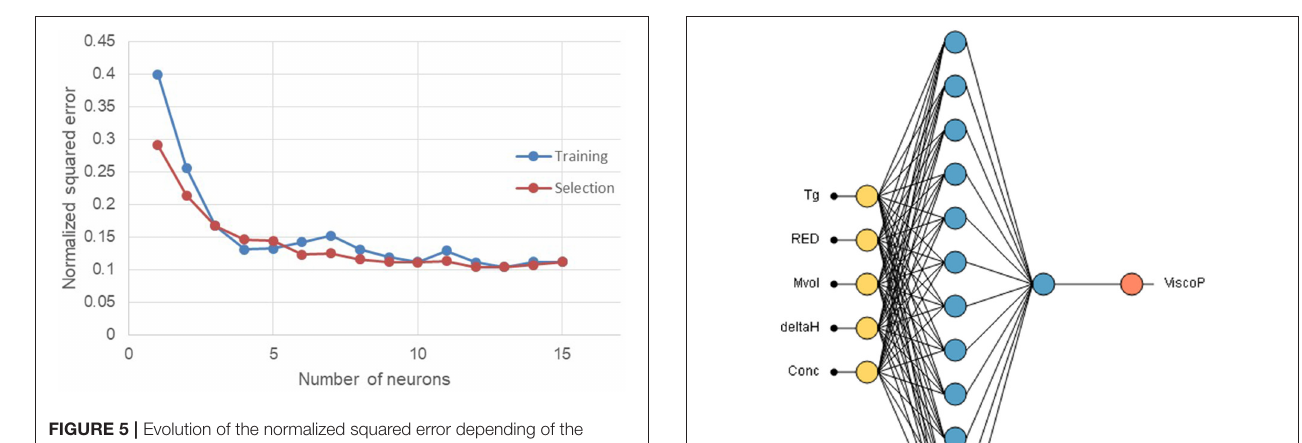
FIGURE 5 | Evolution of the normalized squared error depending of the number of neurons.